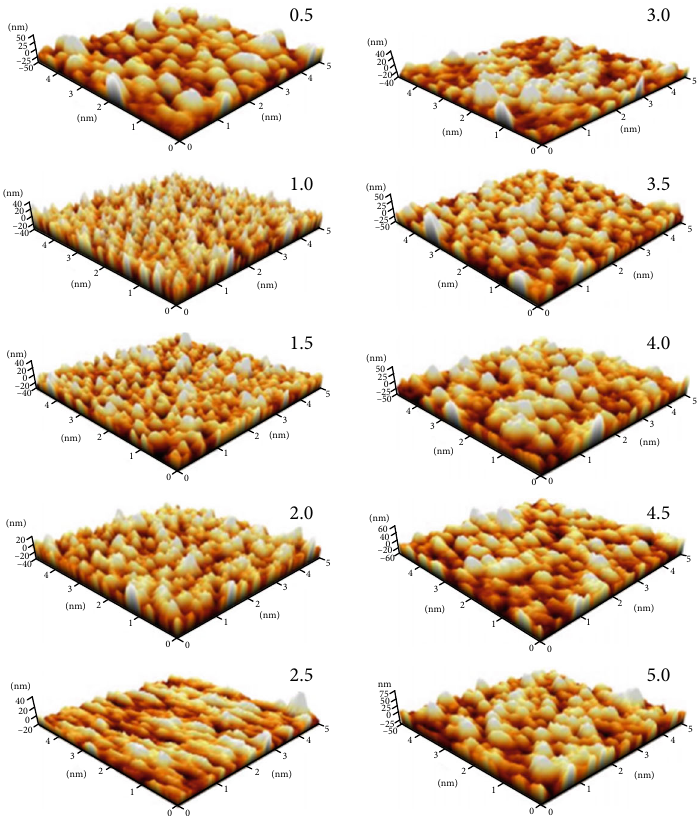
Figure 3: The surface morphology of ITiO fi lms of di ff erent doping concentrations from Ti-0.5wt% to